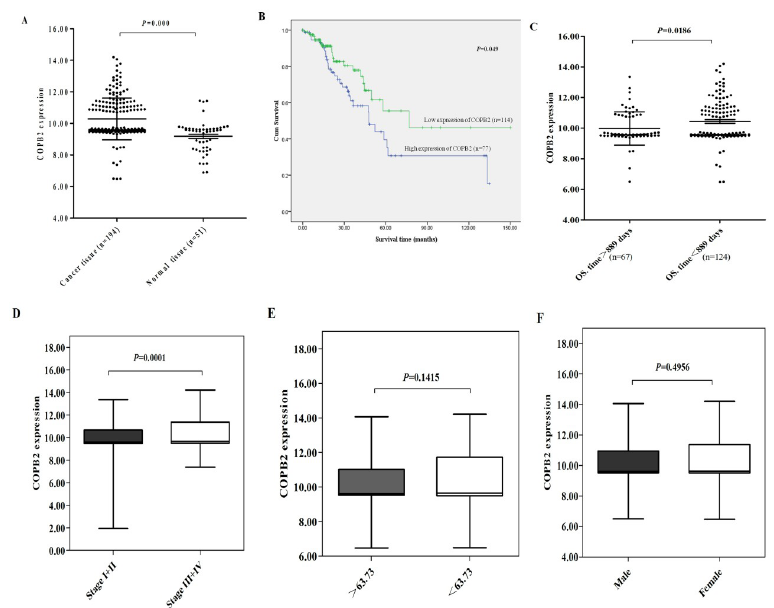
Fig 1. The correlation between COPB2 expression and clinical data of colorectal cancer patients. (A) The expression of COPB2 in colorectal cancer tissues was higher than that in paracancerous tissues. ��� P < 0.001. (B) Kaplan-Meier curves demonstrated that the OS of patients with higher expression of COPB2 is lower than that of patients with lower expression. � P < 0.05. (C) The expression of COPB2 in patients with OS. time > 889 days was lower than that in patients with OS. time < 889 days. (D) Increased expression of COPB2 was correlated significantly with pathological stage of colorectal cancer. ��� P < 0.001. (E-F) The expression of COPB2 was incorrelated with the age and gender of colorectal cancer patients ( P > 0.05).